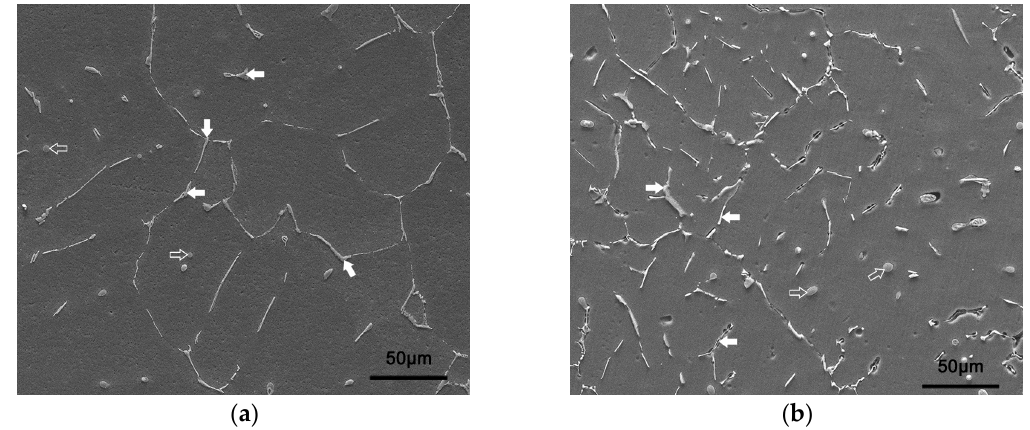
Figure 6. SEM images showing constituent particles in the as-cast recycled Al alloys containing ( a ) 0.1 wt % Fe and ( b ) 0.5 wt % Fe. Table 4. Statistical analysis result of the precipitates limited to a size range from 1 μ m to 200 μ m. Fe Content (wt %)